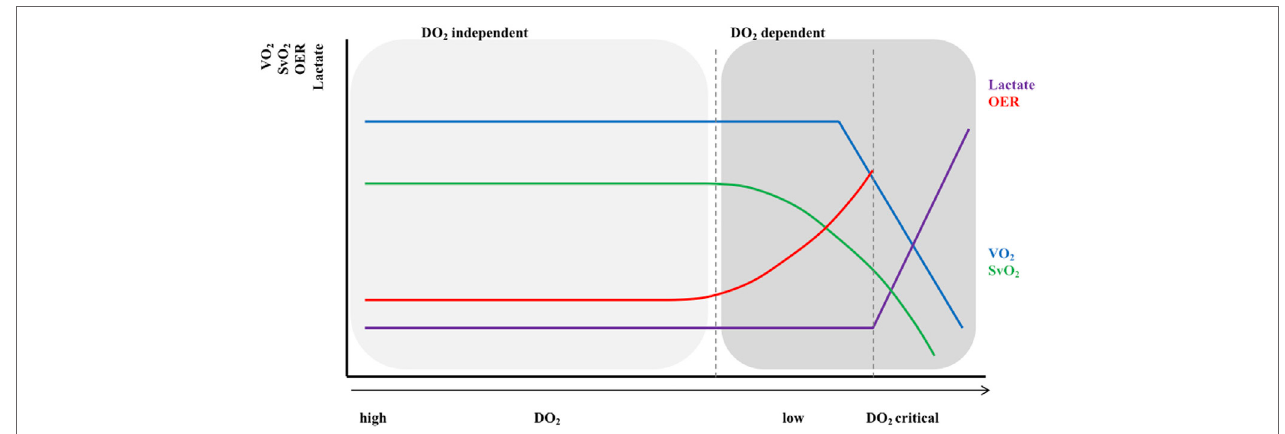
FigURe 1 | Relationship between oxygen delivery and oxygen consumption. VO 2 , oxygen consumption; DO 2 , oxygen delivery; SvO 2 , (mixed) venous oxygen saturation; OER, oxygen extraction ratio. X -axis shows the gradual decrease in DO 2 with the lowest DO 2 on the right side of the figure; Light gray area: VO 2 = DO 2 independent; Dark gray area: VO 2 = DO 2